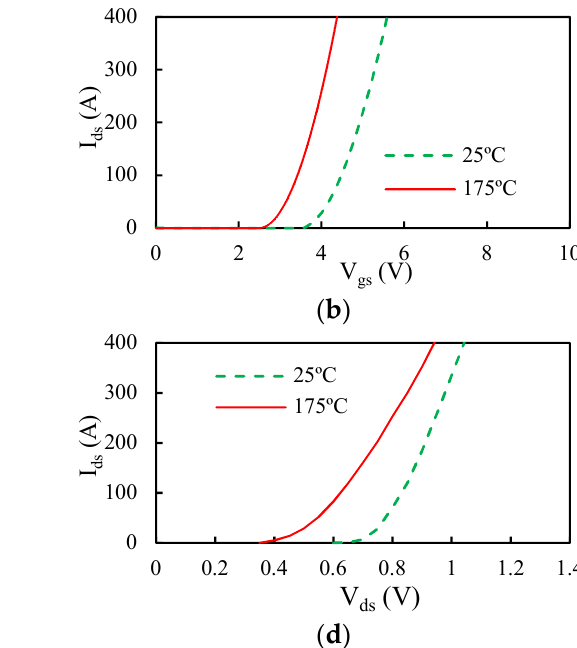
Figure 3. Characteristics of the power MOSFET and body diode presented in the manufacturer’s datasheet and also in [4]: ( a ) power MOSFET output characteristic; ( b ) power MOSFET transfer characteristic; ( c ) power MOSFET on-state resistance; ( d ) diode characteristic.